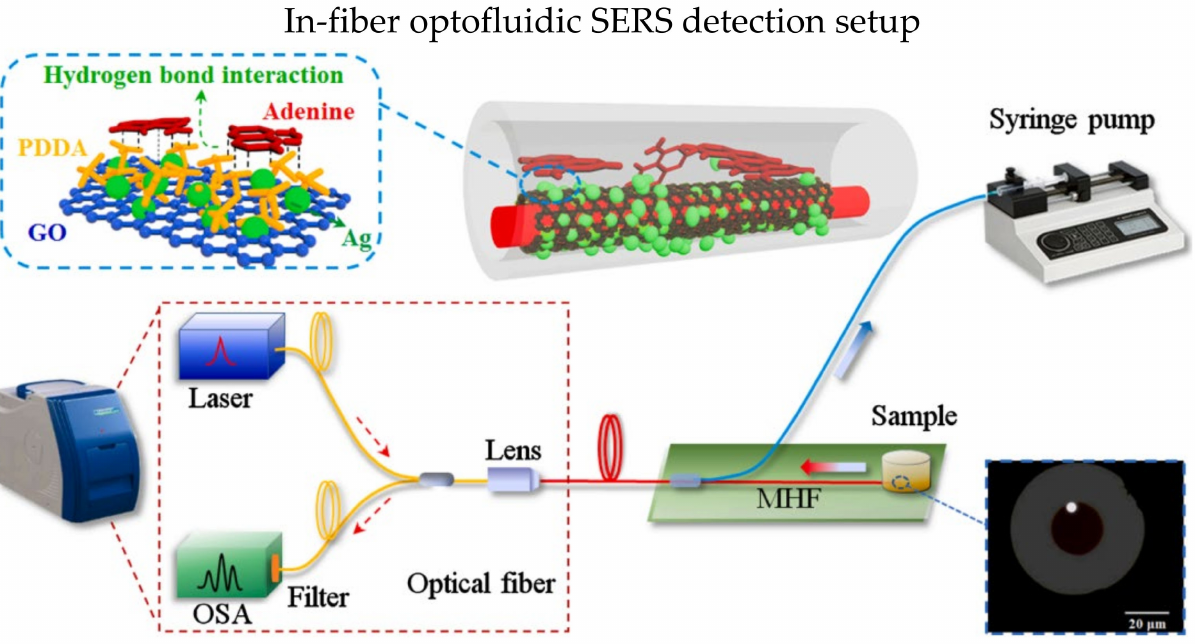
Figure 15. Schematic diagram of SERS-based optical fiber biosensor with optofluidic. Reprinted with permission from Ref. [126]. Copyright 2021,